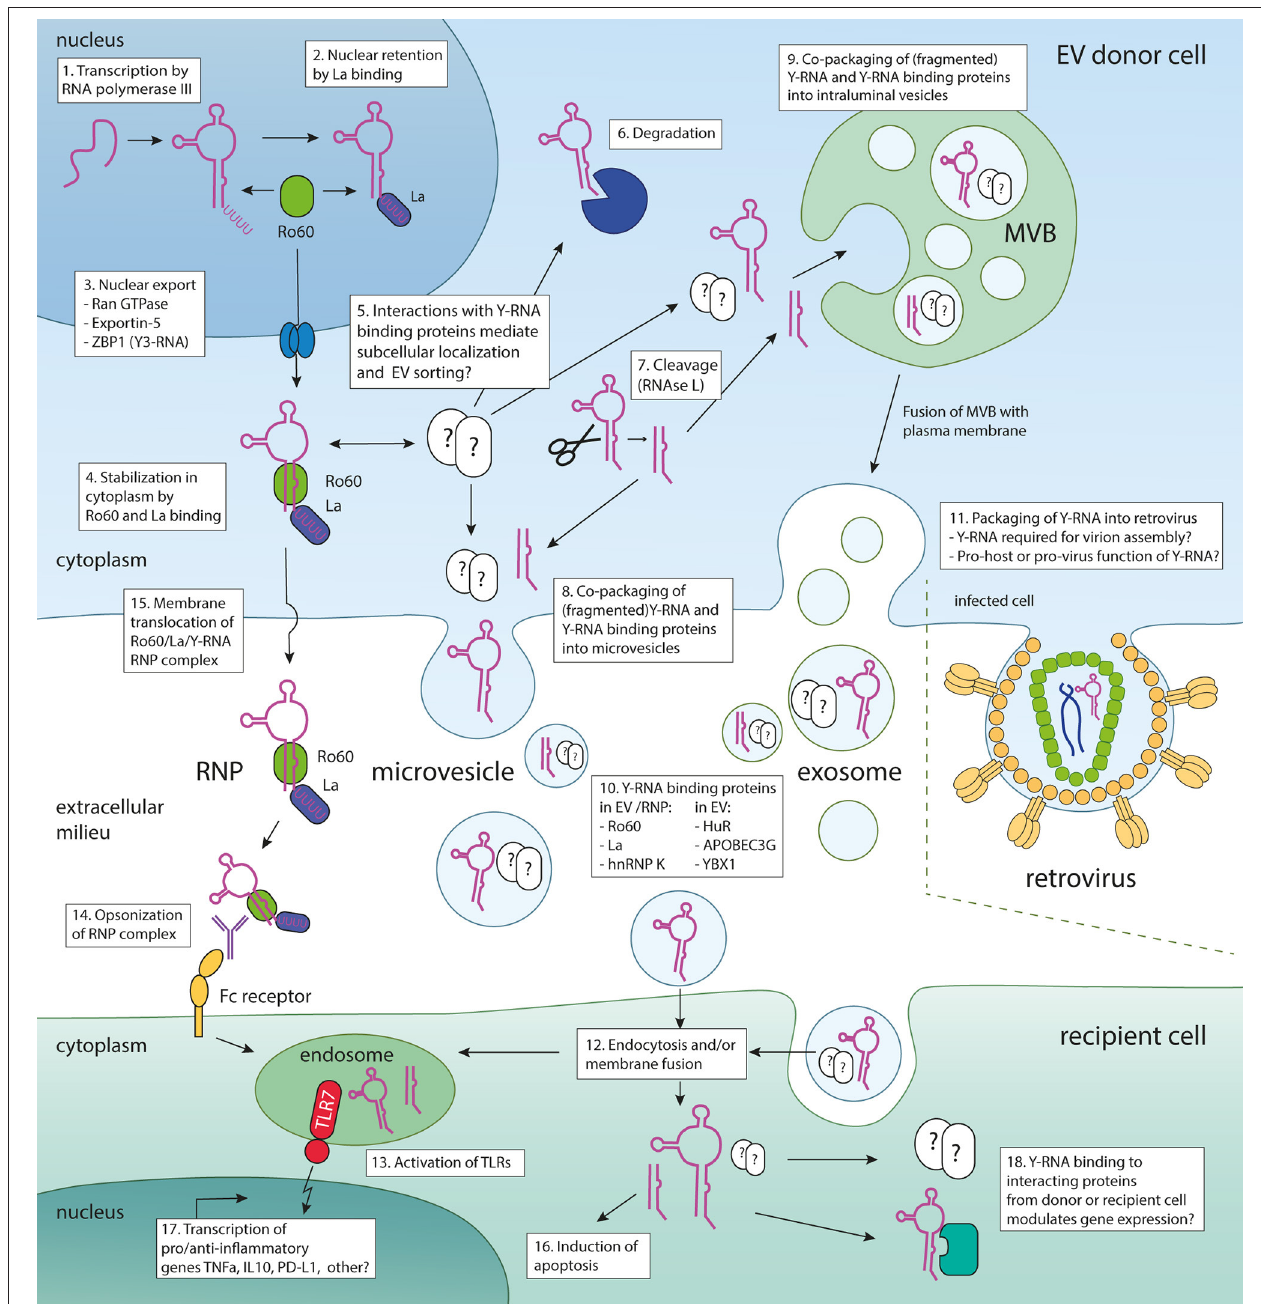
FIGURE 1 | Model illustrating the Y-RNA life cycle, putative pathways for Y-RNA release into the extracellular space, and ideas on the function of Y-RNA transferred to target cells. Various steps in the process of Y-RNA transport within cells and between cells are indicated numerically. Upon transcription (1), newly generated Y-RNA may remain in the nucleus through binding of La (2). Alternatively, upon binding of Ro60, it can be transported into the cytoplasm by Ran GTPase, Exportin-5 and/or ZBP1 (3). In the cytoplasm, Ro60 binding stabilizes Y-RNA (4). Y-RNA can also bind to various other RNA-binding proteins (for instance the Y-RNA binding proteins summarized in Table 3 ) that may influence its subcellular localization and/or fate (5). Y-RNA may be degraded (6), or be cleaved into fragments by RNAse L (7). Both full-length and fragmented Y-RNA are packaged into EV, either via passive engulfment of Y-RNA by budding membranes, or through protein-mediated shuttling toward sites of EV biogenesis [such as the plasma membrane (8) or late endosomes/multivesicular bodies (9)]. Certain proteins known to bind Y-RNA are co-packaged into EV, but others may only serve to shuttle Y-RNA to the sites of EV biogenesis. The Y-RNA binding proteins from Table 3 that have been found in extracellular space, associated with EV and/or RNP are listed in (10). In the case of retrovirus infected cells, Y-RNA may be additionally released from cells by incorporation into virions (11). EV can be taken up by recipient cells by endocytosis and/or membrane fusion (12). Y-RNA may be delivered to the endosome, where it